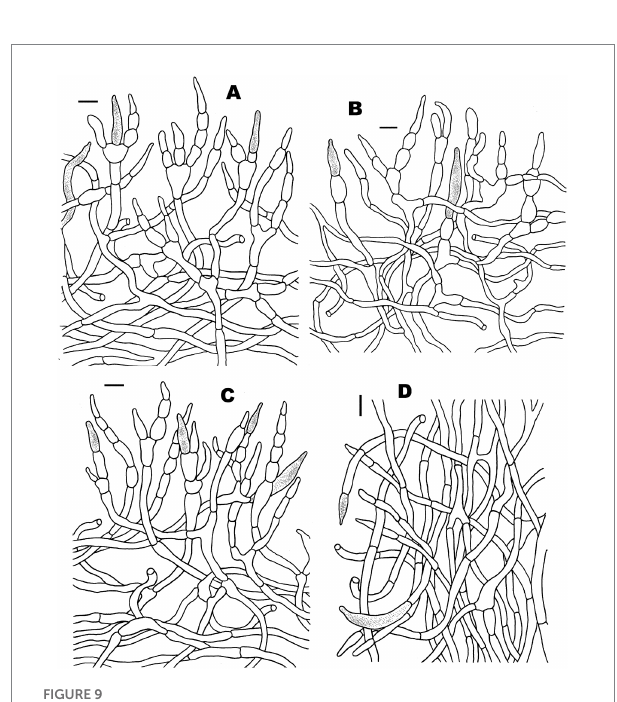
FIGURE 9 Microscopic features of Russula subatropurpurea (FHMU5454). (A) Pileipellis at pileus center. (B) Pileipellis at the middle part between the center and margin of the pileus. (C) Pileipellis at pileus margin. (D) Stipitipellis. Scale bars = 10 μ m. Drawings by Y. X.